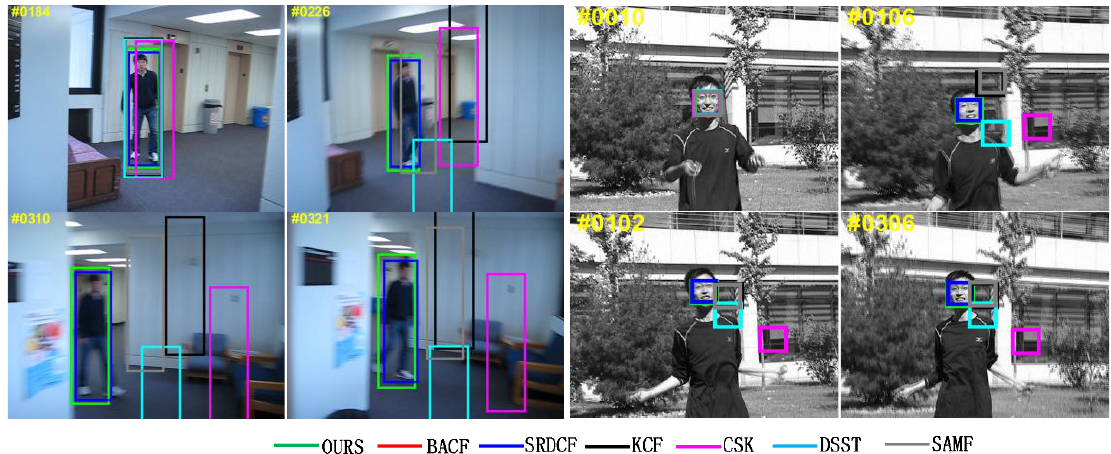
Figure 9. Tracking results of seven trackers on Blurbody ( left ) and Jumping ( right ).